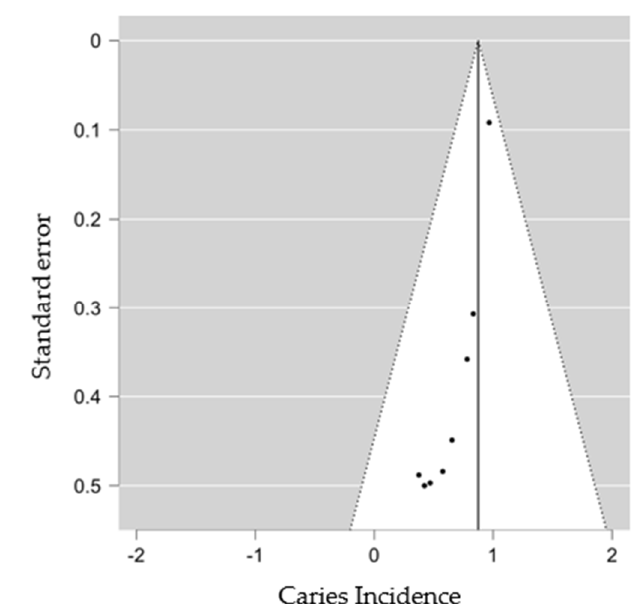
Figure A1. Control group funnel lot.